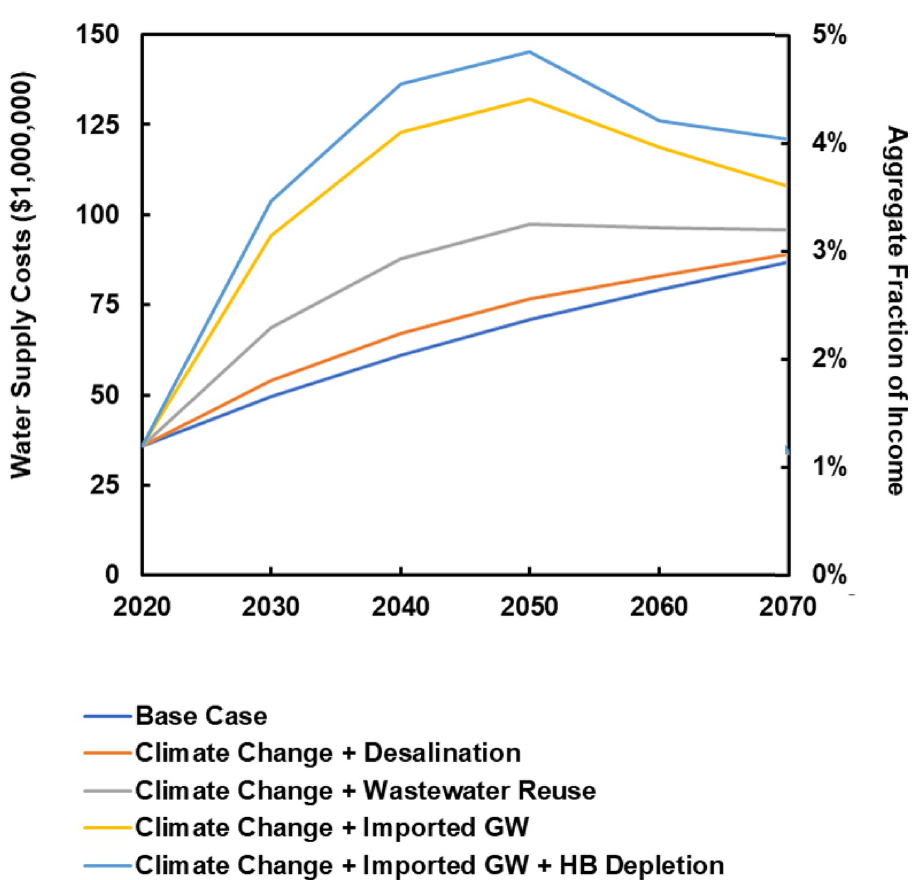
Fig 4. Annual water supply costs and aggregate fraction of income spent on water for service area for each scenario for 2020–2070. Source: Work of the authors.